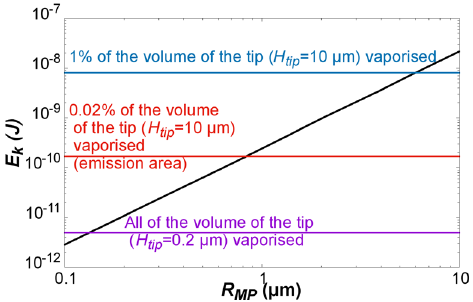
FIG. 16. Kinetic energy of the MP during the crash with the tip versus the MP radius, for I ¼ 0 . 1 μ A, V d ¼ 0 . 5